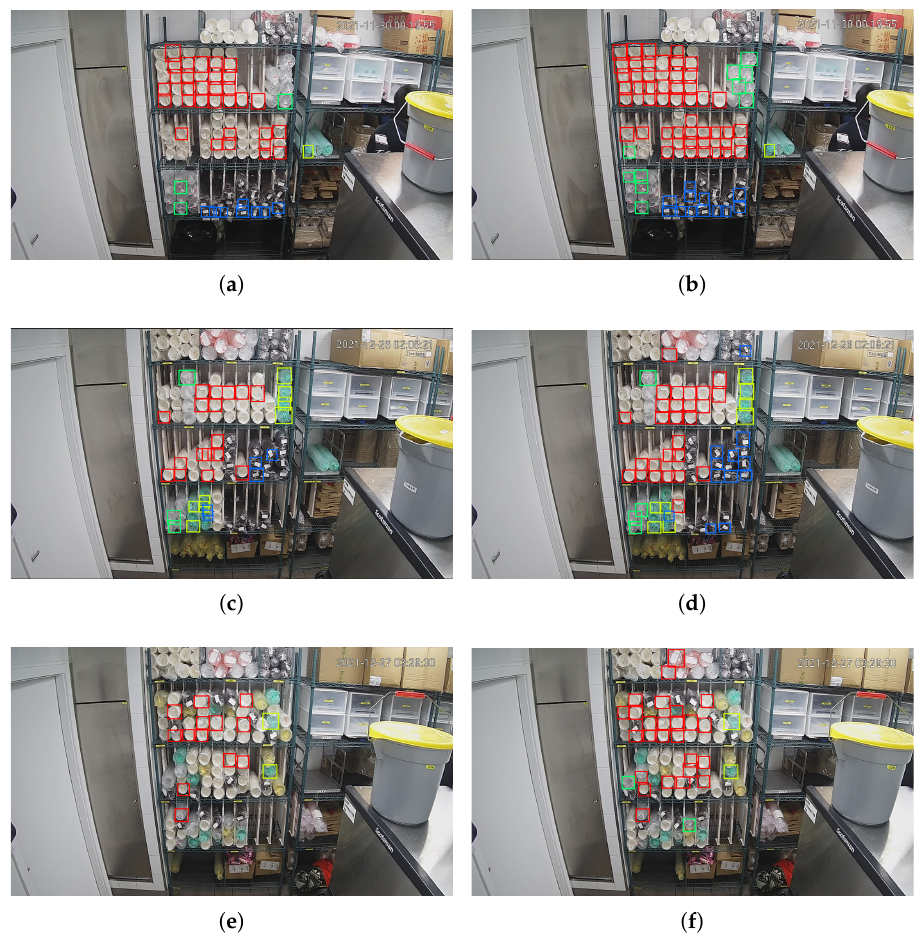
Figure 8. Detection results of SSD algorithm. ( a , c ) Detection results under 0.5 confidence thresh- old and 0.3 NMS IOU. ( b , d ) Detection results under 0.3 confidence threshold and 0.1 NMS IOU. ( e ) Detection results under 0.5 confidence threshold and 0.3 NMS IOU. ( f ) Detection results under 0.3 confidence threshold and 0.1 NMS